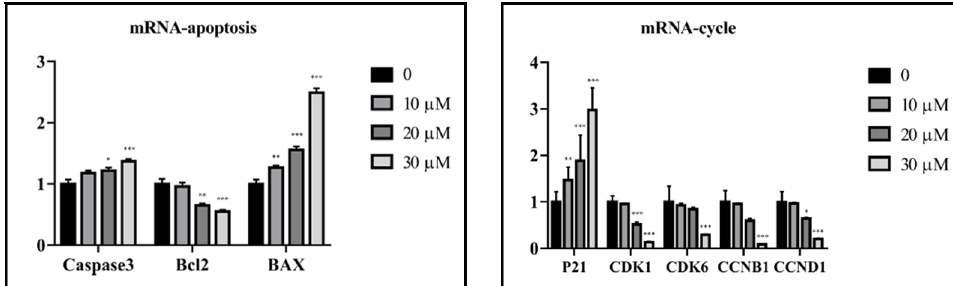
Figure 7. Compound 5 affected the gene expression of proliferative and apoptosis factors in HCT116